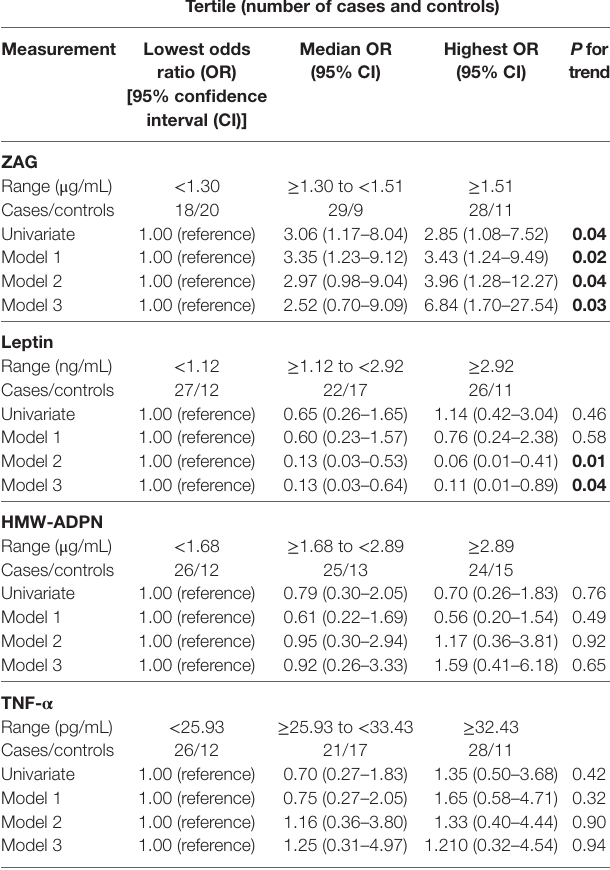
TaBle 4 | Unconditional logistic regression analysis of colorectal cancer risks according to tertiles of zinc- α 2-glycoprotein (ZAG), leptin, high-molecular-